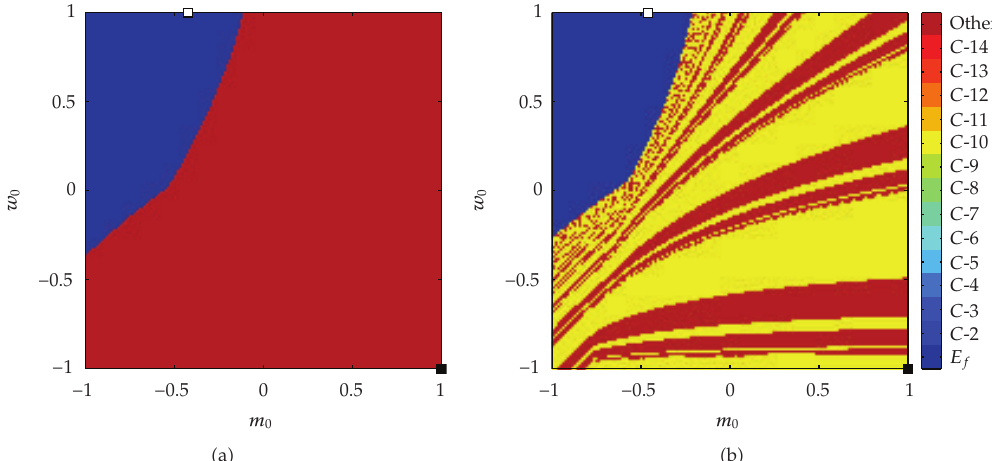
Figure 10: Basins of attraction in the plane (cid:2) m 0 ,w 0 (cid:3) for x 0 (cid:9) 1 . 3, a (cid:9) 0 . 1 and the other parameter values as in Figure 5. (cid:2) a (cid:3) β (cid:9) 1 . 8, (cid:2) b (cid:3) β (cid:9)